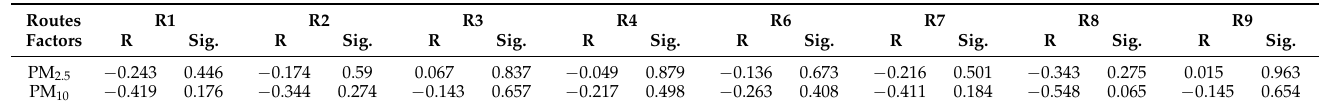
Table 2. The correlation coefficient analysis results between passenger number and average PM concentrations in the same metro carriage on different